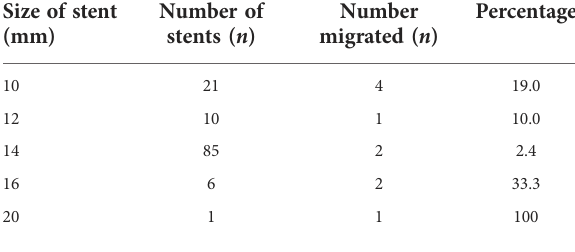
TABLE 2 Distribution of stent migration according to stent size. Size of stent (mm)